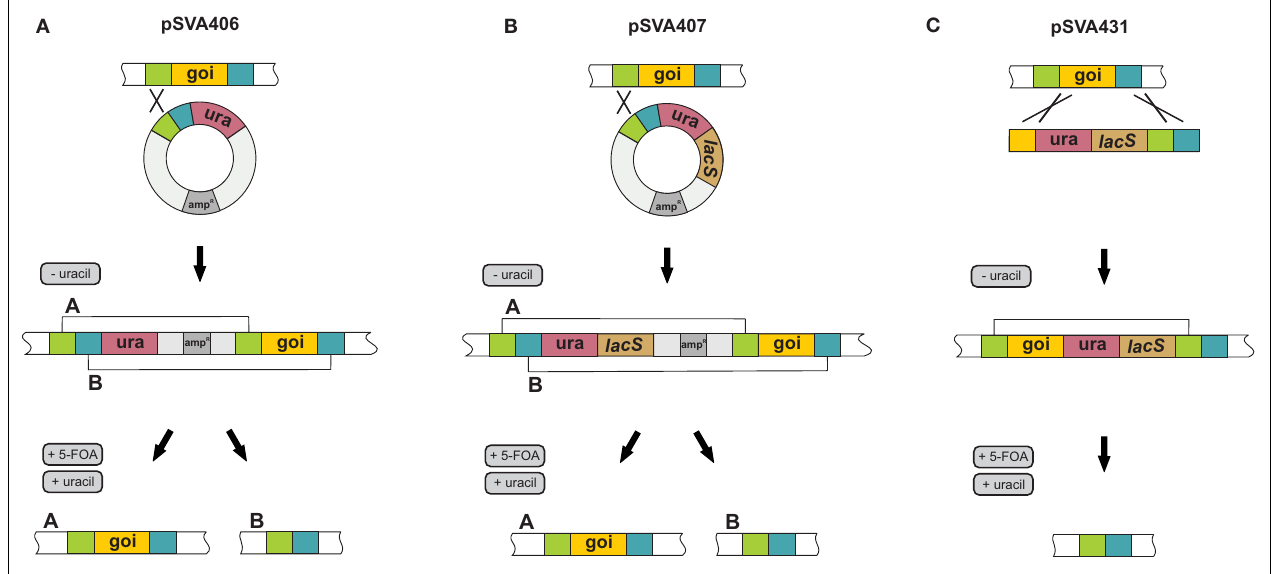
integrants at the first selection level. (C) pSVA431 allows for double crossover insertion via the sequence of the gene and a downstream region of the gene of interest of the selection cassette.Thereby positives clones should be staining blue. Upon selection on 5-FOA plates the selection cassette will be excised and positive deletion mutants should be white. Goi, gene of interest; ura, pyrEF sso cassette; amp, ampicillin resistance cassette for selection in E.coli